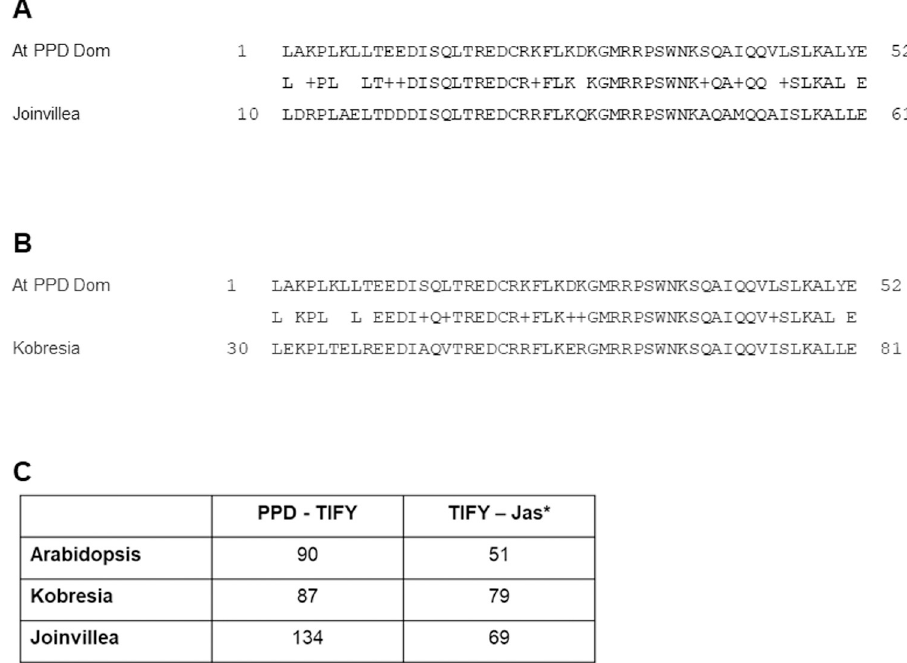
Fig 7. Comparison of the protein domains of putative Joinvillea ascendens and Kobresia littledalei PPDs with Arabidopsis PPD1. A. & B. The PPD domain from Arabidopsis aligned with putative PPD domains from J . ascendens (A) and K . littledalei (B). The J . ascendens alignment gave 75% identities and 88% positives, while K . littledalei gave 79% identities and 90% positives. C. The distance between domains is altered in Kobresia and Joinvillea compared to Arabidopsis, a notable feature being the greatly increased spacing between PPD and TIFY domains for the Joinvillea protein in contrast with the Arabidopsis sequence.